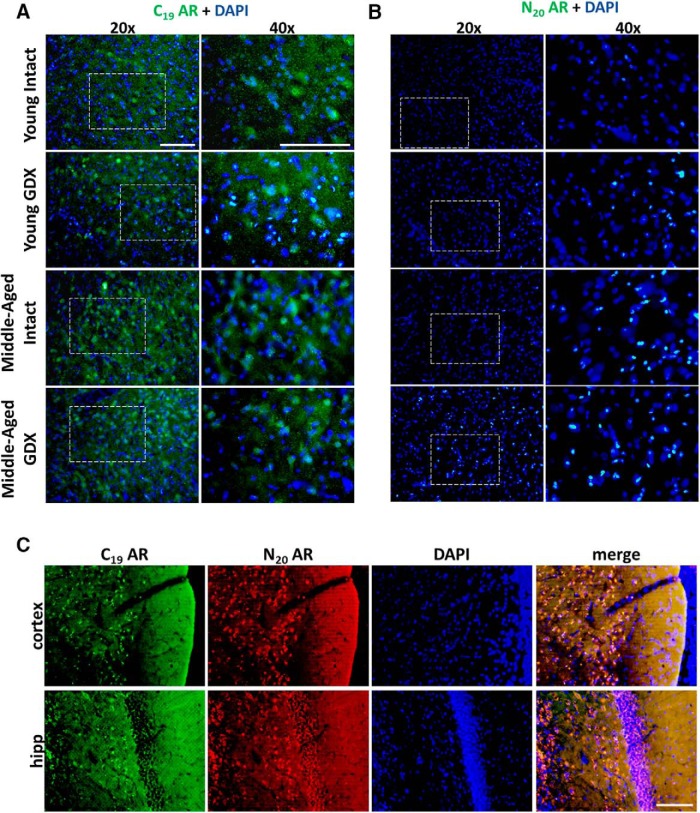
Widespread AR45 distribution in the substantia nigra. AR immunoreactivity using a CTD targeted antibody (AR C19) was observed throughout the SN in all age and hormone groups (A). No AR immunoreactivity was observed using a NTD targeted antibody in the SN (B). Both the hippocampus and the ETC express CTD and NTD AR immunoreactivity that is present within the nucleus, as evidenced by DAPI colocalization (C). SN, substantia nigra pars compacta; ETC, 2nd layer of the entorhinal cortex; Hipp, CA1 region of the dorsal hippocampus. Scale bar = 200 μm.